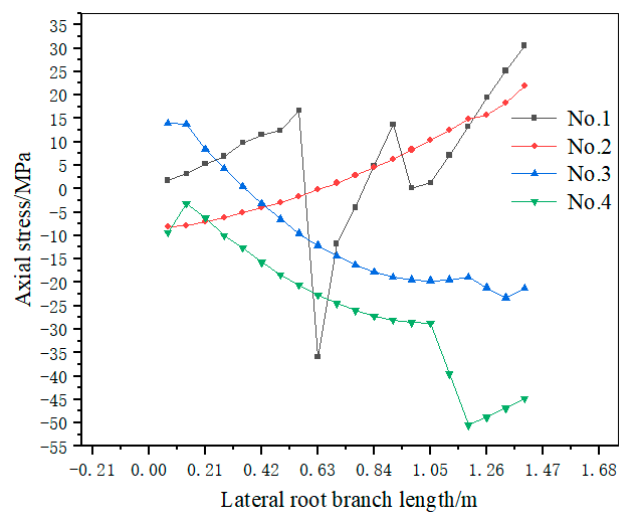
Figure 10. The stress of the first layer lateral roots of the 3 m tap root.